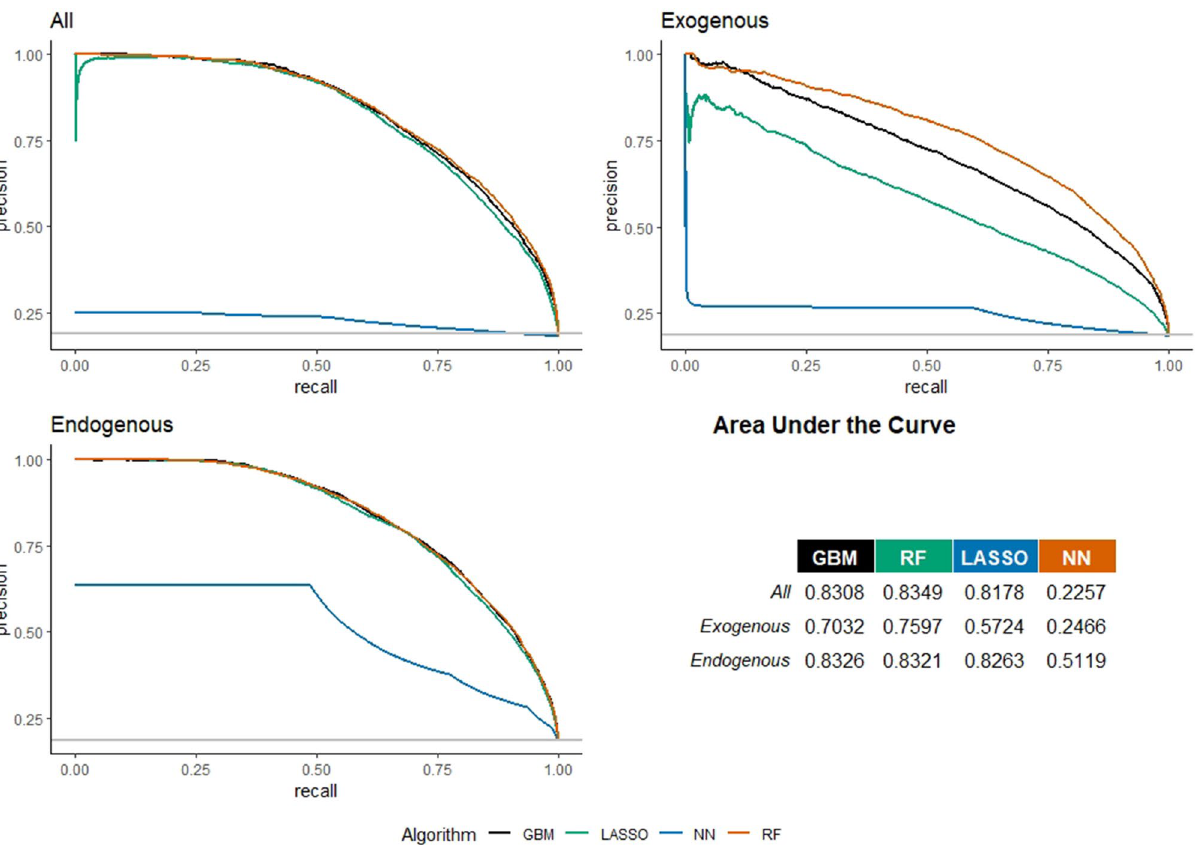
Figure 7. Precision–recall curves for European universities’ co-publication prediction in Multidisciplinary Science. Three models considered: with all, with only exogenous, and with only endogenous